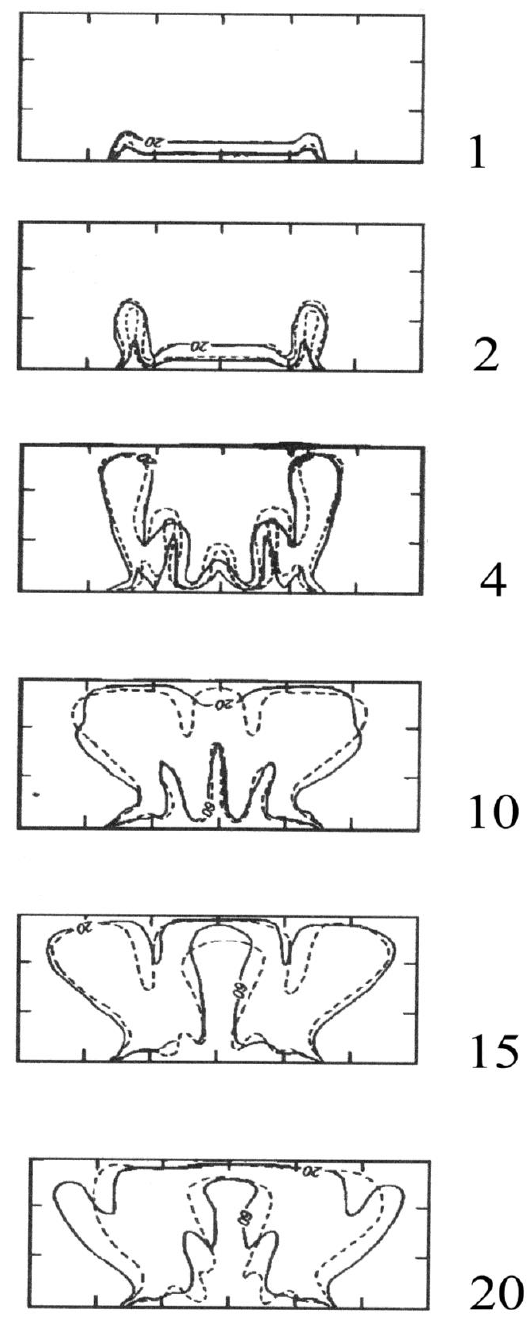
Figure 4. Numerical model, Voss and Souza (1987) [9], A = 400: compare Figure 2. SUTRA solid lines. Elder (1967) [2] dashed lines. Here, salinity model results from Voss and Souza (1987) [9] are shown upside down to correspond with the original thermal model. Salinity distributions are given for different times in nominal years: 1 year = 0.005 dimensionless time. [Modified from Figure 9a of Voss and Souza (1987) paper [9]. Reproduced with permission from Voss, C.I. and Souza, W.R., Variable Density Flow and Solute Transport Simulation of Regional Aquifers Containing a Narrow Freshwater-Saltwater Transition Zone; published by American Geophysical Union, 1987.]